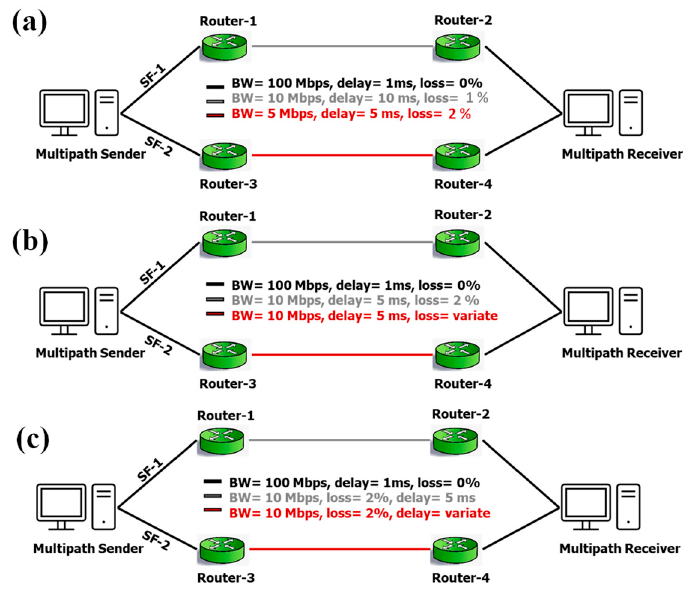
Figure 1. Scenarios for evaluating the considered schedulers ( a ) Scenario #1, ( b ) Scenario #2, and ( c ) Scenario #3. ( c ) Scenario